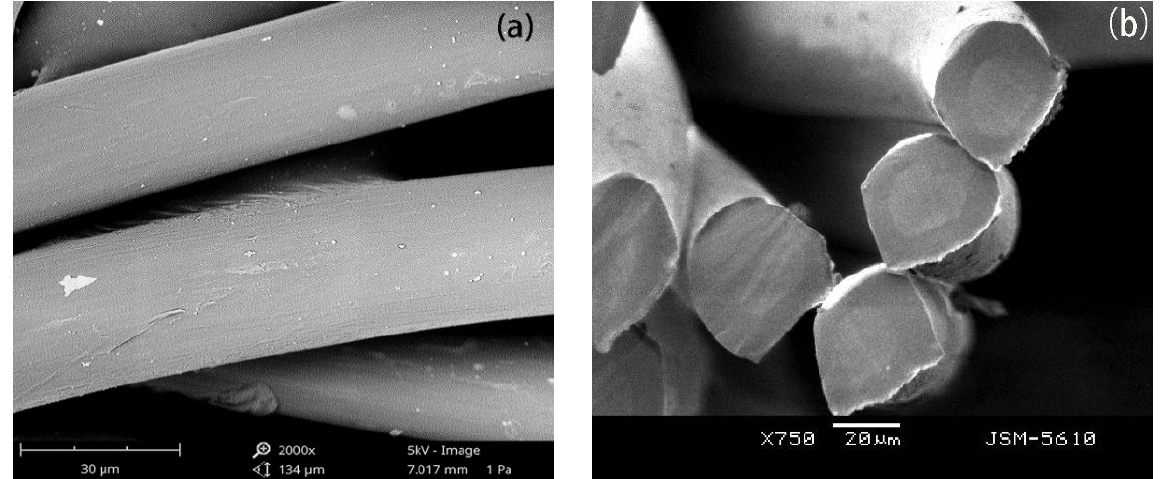
Figure 2. Surface and cross-sectional morphology of the PCTF ( a ) surface view ( b ) cross-sectional view. The relationship between the mass and the temperature of the PCTF is given in Figure 3. The TG curve of the PCTF had two stages. In the process of its temperature rise, the PCTF transformed from solid phase to liquid phase at 22–31 ◦ C, and this